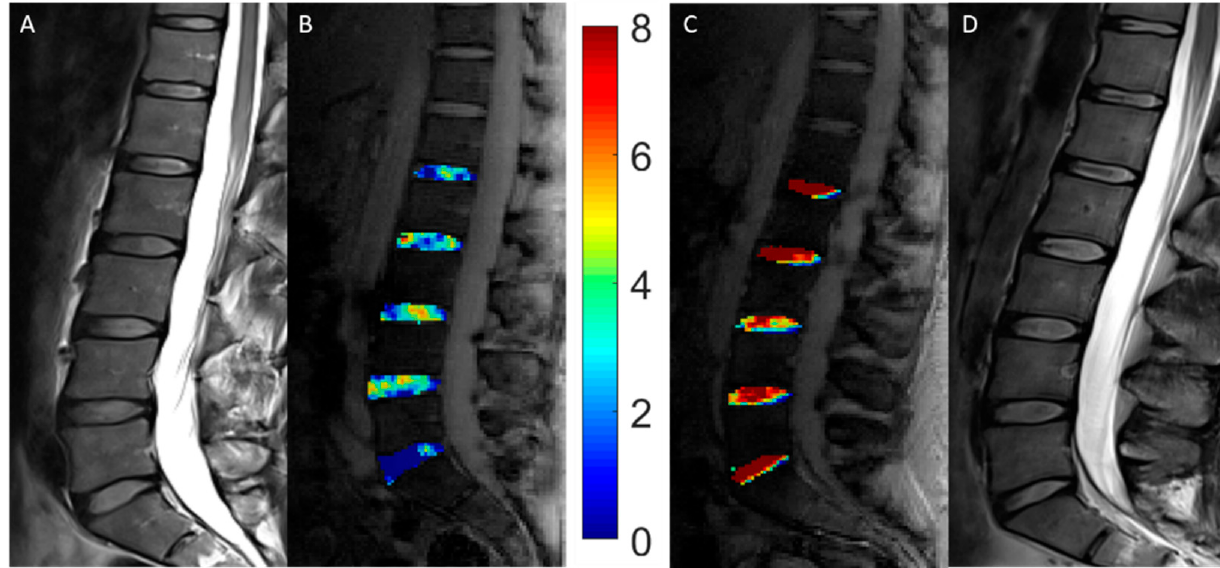
Mean glycosaminoglycan chemical exchange saturation transfer (gagCEST) values of the two study cohorts (i.e., 16 healthy controls and 10 AIS patients) in all patients as a function of segment levels. Using linear mixed models including a subject-specific intercept, mean gagCEST values were compared. Data are corrected mean + 95% confidence interval [square brackets] (%) of gagCEST values of the nucleus pulposus (NP). The covariates were corrected for an age of 23.1 years. p -values < 0.05 are given in bold type. Abbreviations: L—lumbar; n/a—not applicable.